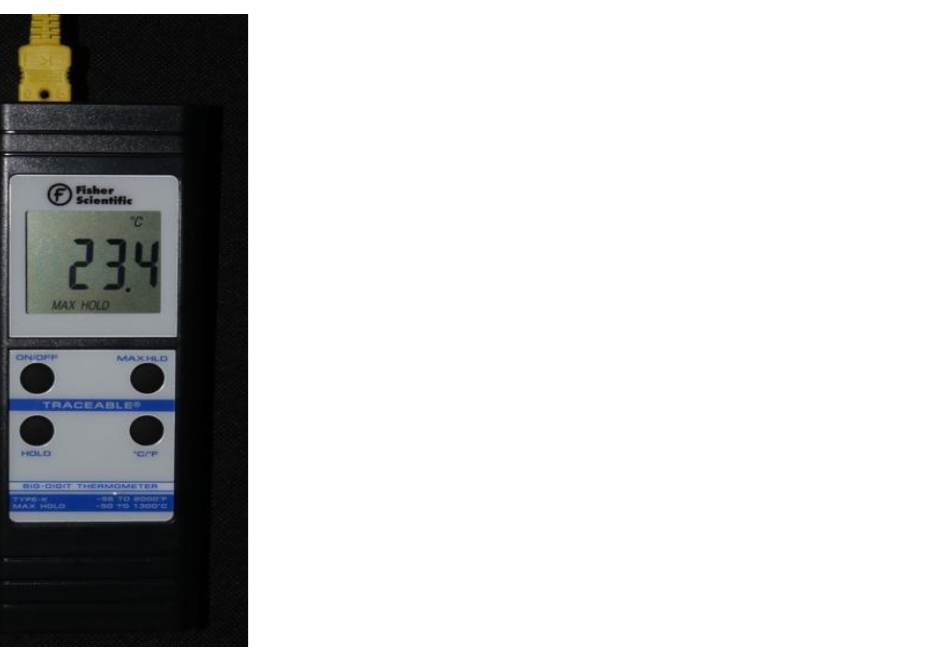
Figure 2. K-type thermocouple (Fisher Scientific 15-078-187, range − 58 to 2000 °F, resolution 0.1°/1°, sampling rate 2.5 times per second) with an ultra-fast response naked bead probe that was used to measure the temperature.